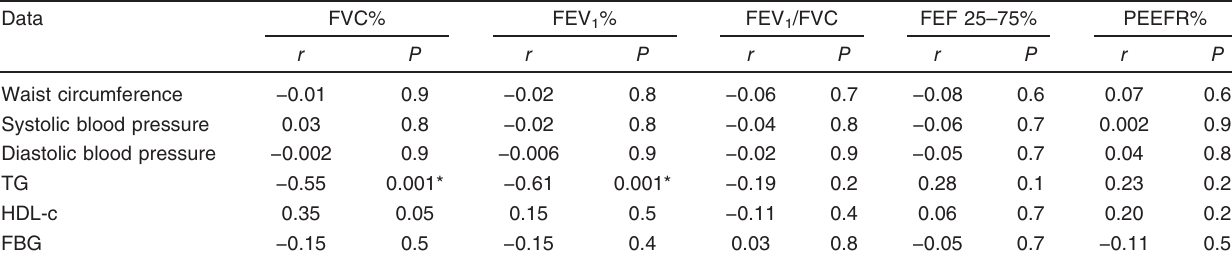
Table 4 Correlation between spirometry and metabolic syndrome criteria among patients with metabolic syndrome